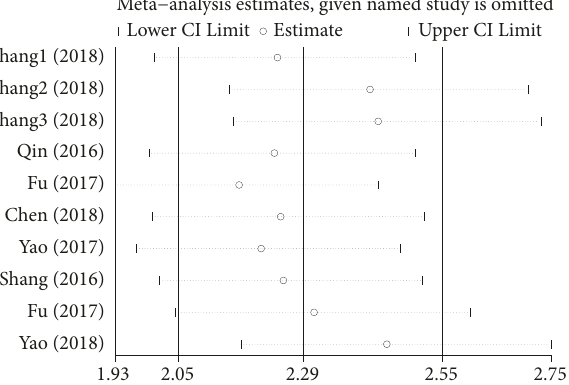
Figure5:Sensitivityanalysisoftheoverallpooleddiagnosticstudies (outlier detection